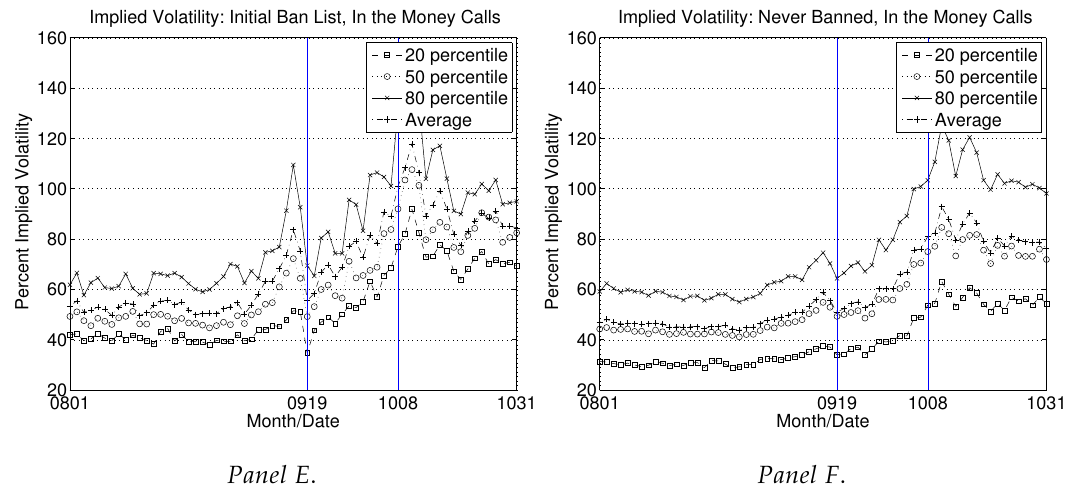
Figure 7. Time series of cross sectional options summary statistics: In the money call options of Initial Ban List and Never Banned Stocks during the ban and non-ban periods: ( A , C , E ) results for the three variables for Initial Ban List Stocks; and ( B , D , F ) results for the three variables for Never Banned